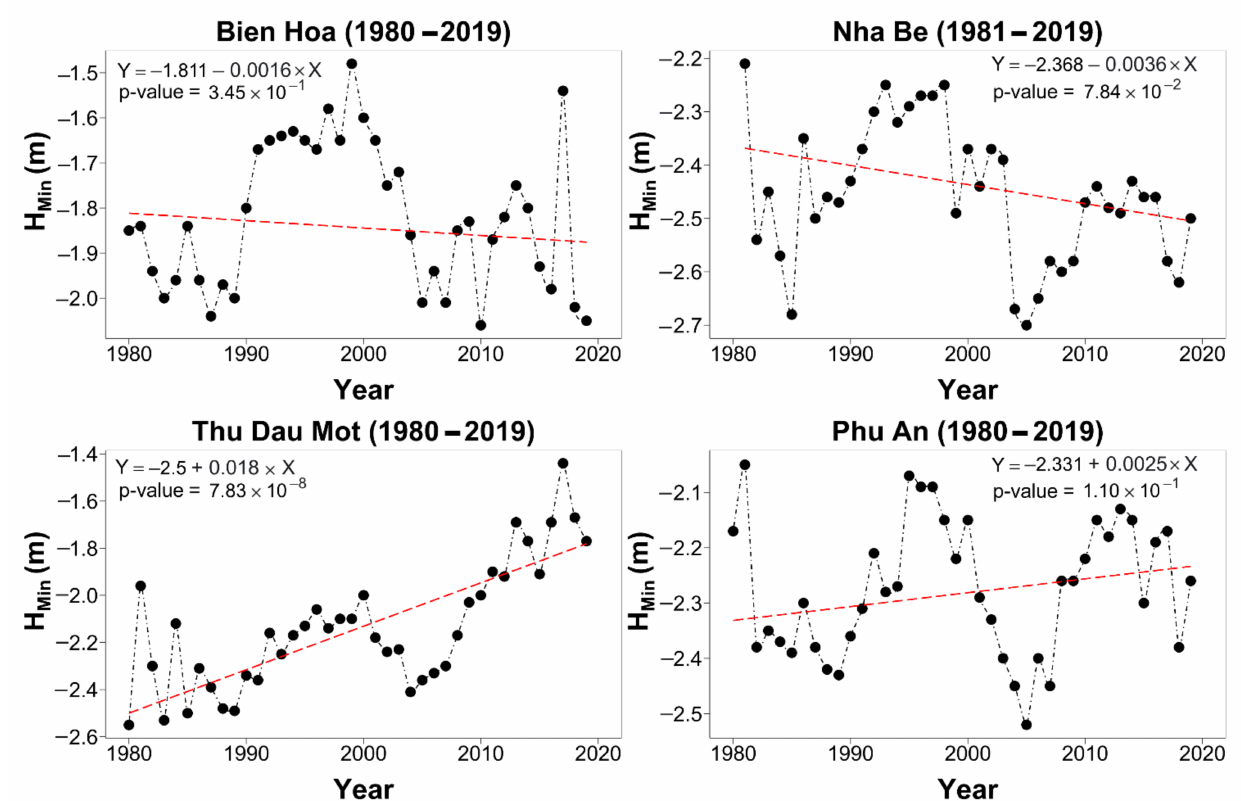
Trend of H p1% , H min (Minimum Water Level)